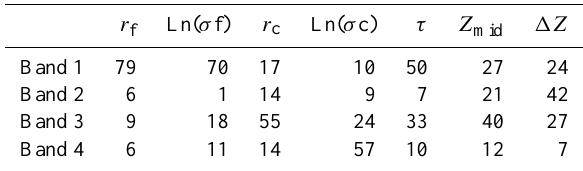
Table 5. Band-by-band repartition of IC (in %) for dust particle parameters above desert